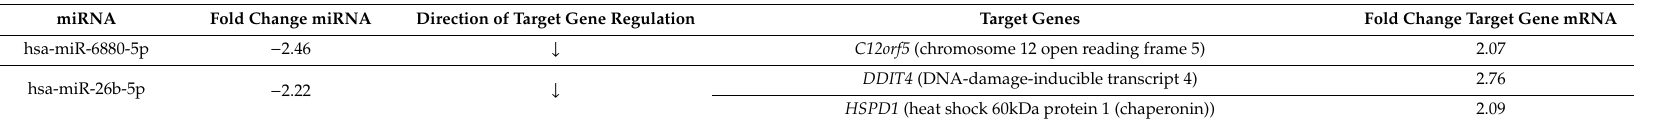
Table 8. The list of most dysregulated miRNAs with their targets involved in neuron death, in bortezomib-treated SH-SY5Y cells compared to controls. Presented miRNAs downregulate expression of their target genes, hence the direction of target genes regulation is marked as “ ↓ ”. Since all miRNAs have decreased expression (negative fold change), the downregulation of their targets is not prominent and therefore they present with positive fold change, which indicates increased expression of genes related to neuron death.